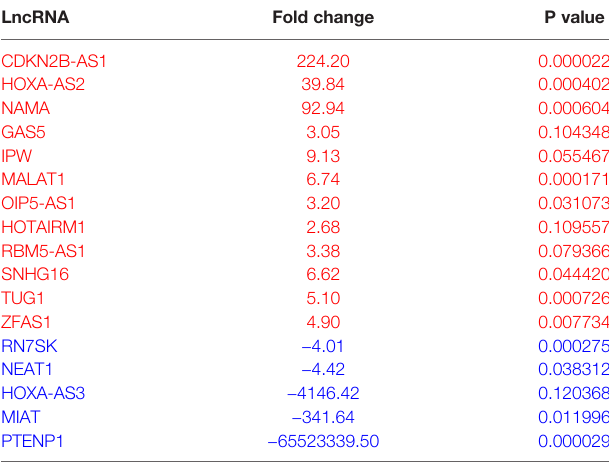
Upregulated lncRNAs are highlighted in red and downregulated lncRNAs are highlighted in blue.